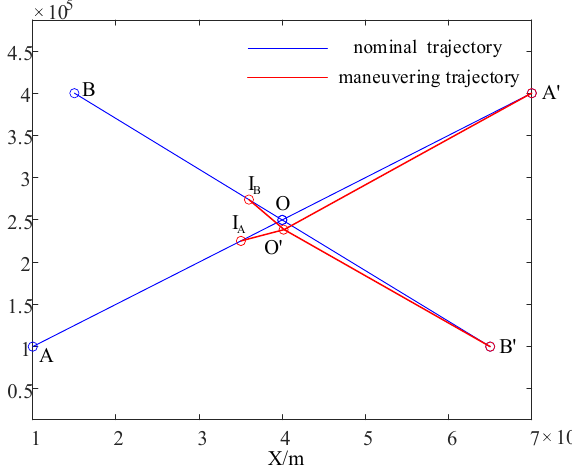
Figure 9. Trajectory diagram of maneuver separation assurance strategy at priority 2:1.